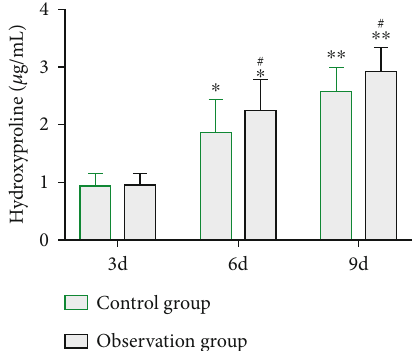
Figure 4: Hydroxyproline content in the wound in the two groups. ∗ P < 0 : 05 vs. the level after 3 days of therapy; ∗∗ P < 0 : 01 vs. the level after 3 days of therapy; # P < 0 : 05 vs. the control